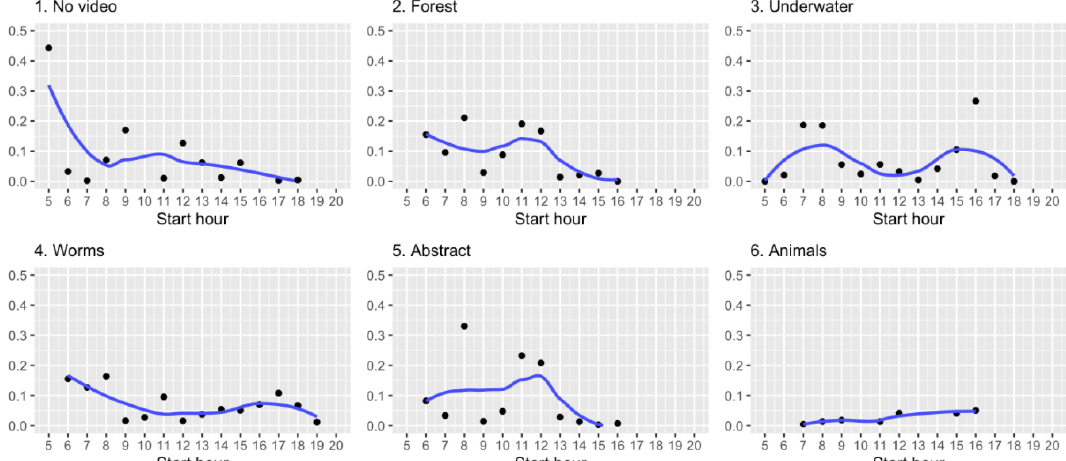
Figure 6. Monkey’s daily usage of the system per hour over different stimuli. Line shows average fitted